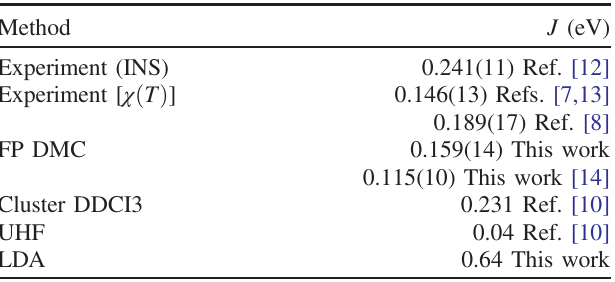
TABLE I. The nearest-neighbor spin superexchange coupling constant J of Ca 2 CuO 3 and Sr 2 CuO 3 obtained with different theoretical (Ca 2 CuO 3 ) and experimental (Sr 2 CuO 3 ) methods. The abbreviations used are INS, inelastic neutron scattering; FP DMC, fixed-phase diffusion Monte Carlo; DDCI3, difference- dedicated configuration interaction with three degrees of free- dom; UHF, unrestricted Hartree-Fock; LDA, local density approximation. χ ð T Þ denotes a temperature-dependent magnetic